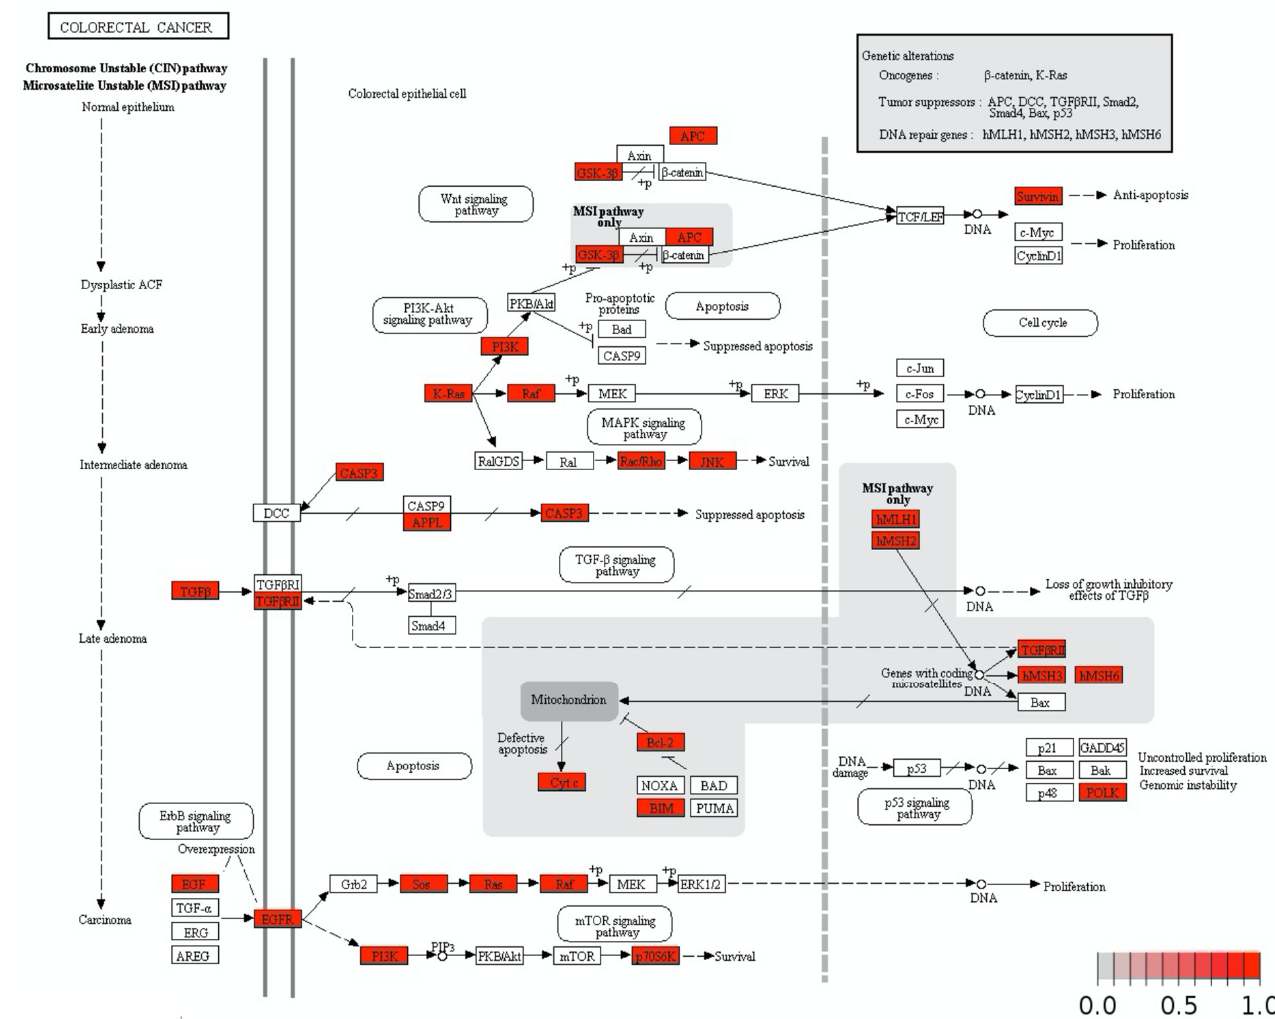
Figure 7. Integrated pathway analysis of the 555-overlapping CMS1 gene signature showing positive correlations with numerous genes in CRC signaling pathways. The 555 overlapping genes have strong positive correlations with gene regulators that activate PI3K-AKT signaling, ErbB signaling, TGF β signaling pathways, and mismatch repair genes.